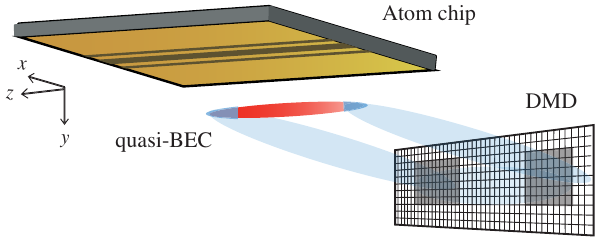
FIG. 6. Illustration of the experimental setup. The cloud of 87 Rb atoms is trapped below the atom chip whose current-carrying wires generate a cigar-shaped potential. In our convention, the longitudinal direction is labeled as z and the transverse directions as x and y . Here, gravity acts along the y axis. A blue-detuned laser light is shined onto the atoms along the x direction; using the DMD, its beam front is shaped to create the desired potential along the longitudinal